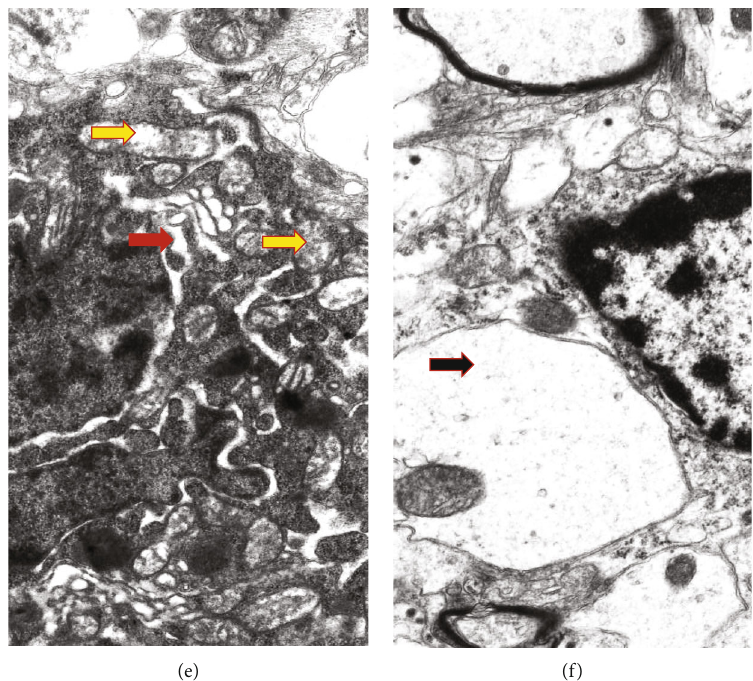
Figure 4: Ultrastructural changes of VMH neurons and glial cells were assessed by electron microscopy observations. Gallery of micrographs obtained by SEM ( n = 12 neurons for each group): (a – c) control rats; (d – f) rats from the T2DM group. Representative images of neurons are presented on (a, b, d, e) and glial cells on (c, f). The red arrows indicate the rough endoplasmic reticulum, yellow arrows — mitochondria, and black arrows — neuropil swelling. Scale bar: 200